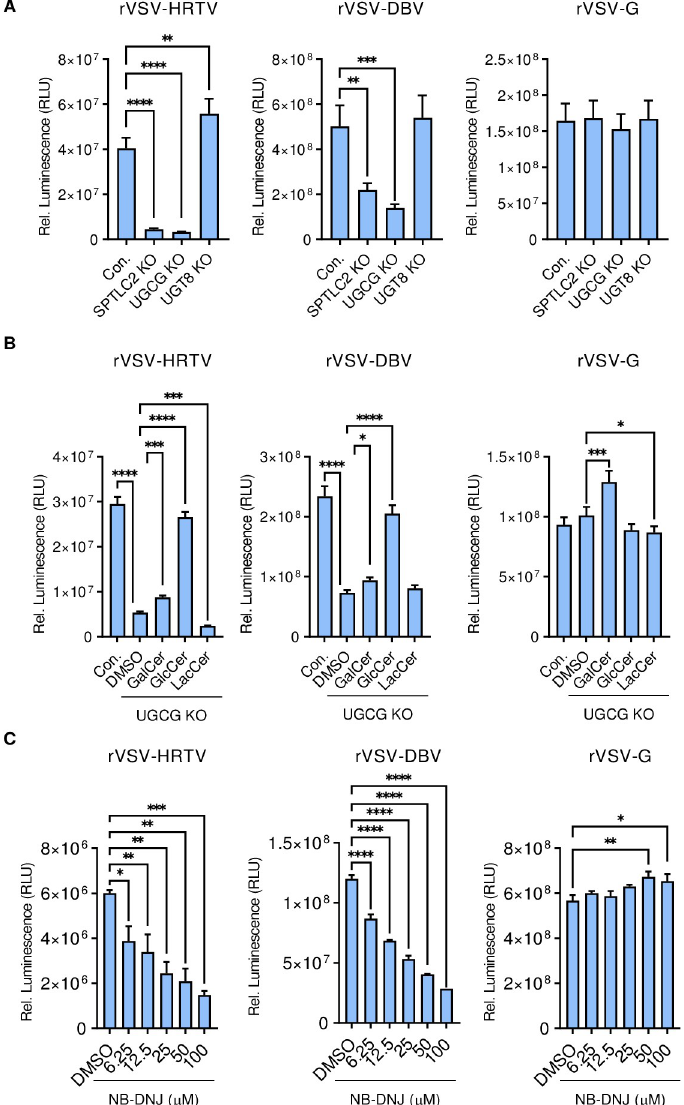
Fig 7. HRTV glycoproteins are responsible for GlcCer-mediated membrane fusion. A. Effect of SPTLC2-, UGCG- or UGT8-deficiency on rVSV-HRTV, rVSV-DBV, and rVSV-G entry. Control and KO 293T cells were infected with the indicated virus for 24 hours, followed by luciferase assay. Luminescence readings were normalized to the respective cell numbers. B. Rescue of rVSV-HRTV and rVSV-DBV entry in UGCG KO cells. Control and UGCG-KO 293T cells were cultured in media supplemented with 50 μ M indicated glycosphingolipid for 24 hours, followed by infection with the indicated virus for additional 24 hours for luciferase assay. C. Effect of NB-DNJ treatment on rVSV-HRTV, rVSV-DBV, and rVSV-G entry. 293T cells were treated with indicated concentrations of NB-DNJ for 24 hours, followed by infection with the indicated virus for 24 hours prior to luciferase assay. All the data shown are means ± SEM from representative experiments (n = 3 technical replicates). P values were determined by ordinary one- way ANOVA with Dunnett’s multiple comparison tests. ���� , P < 0.0001; ��� , P < 0.001; �� , P < 0.01; � , P < 0.05.